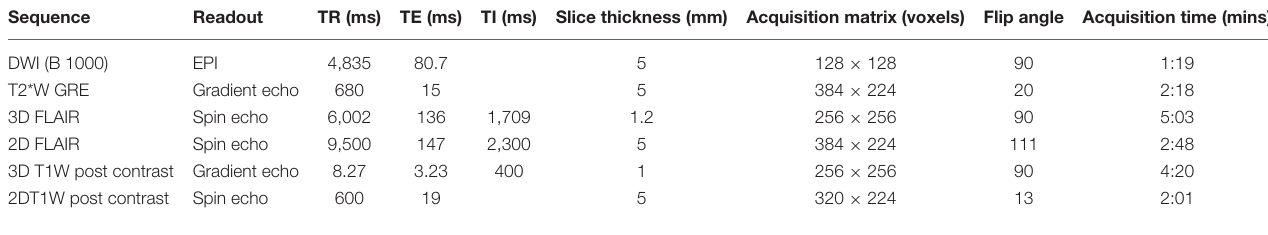
TABLE 3 | Sequence